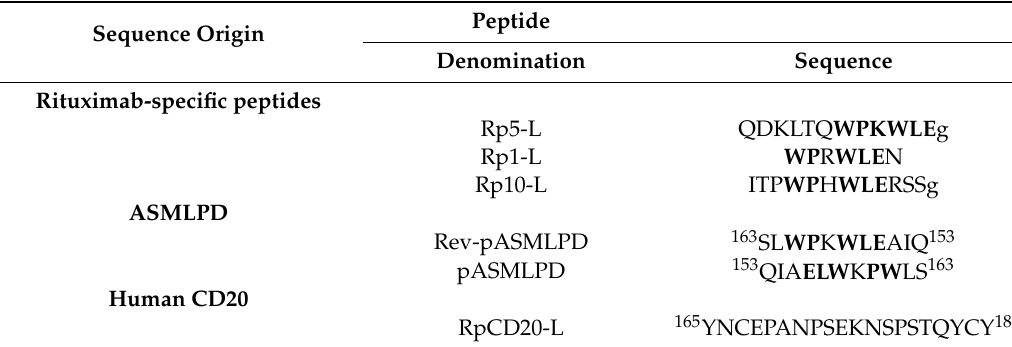
Figure 1. ( A ) Specificity of the reactivity of sera antibodies elicited in a BALB / c mouse immunized with Rituximab-specific peptide Rp5-L. 10-fold serial dilutions of serum were added to wells previously coated with Rp5-L peptide (closed triangle). Following a 4h incubation at R / T, bound antibodies were detected with horseradish peroxidase (HRP)-conjugated goat anti-mouse IgG. The Qp-1a peptide was used as a negative control (open triangle). ( B ) The occurrence of anti-CD20 Ab in serum from mice immunized with Rp5-L. Anti-Rp5-L serum (diluted 1:20) was added to rabbit IgG-treated CD20 + B lymphoid Raji cells. Bound antibodies were detected with an appropriate dilution of fluorescein isothiocyanate (FITC)-conjugated goat anti-mouse IgG. Rituximab, the anti-HLA class I mAb TP25.99 and the CD20 − human T lymphoid CEM cells were used as controls. Table 1. Peptides used in the immunochemical